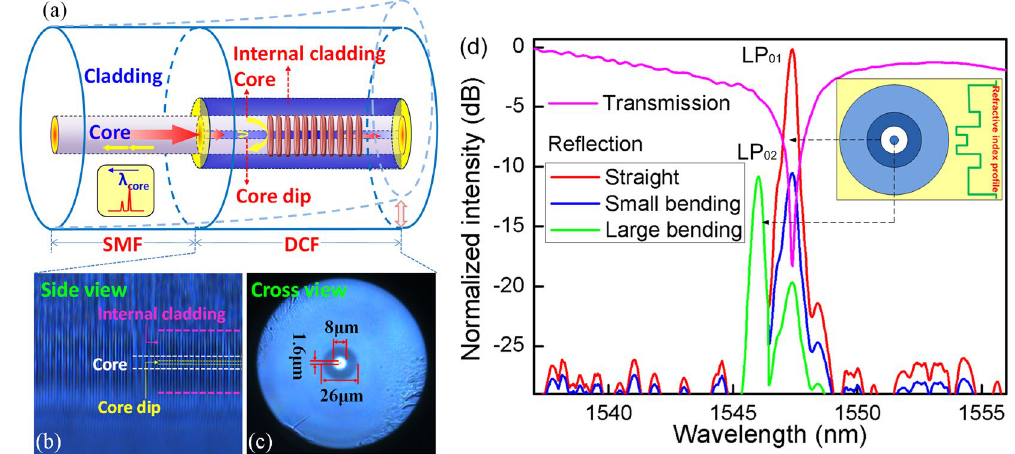
Figure 1. ( a ) Schematic of the DCF-FBG accelerometer, ( b ) side-view images of the DCF with grating inscription, ( c ) cross-view image of DCF, ( d ) transmission and reflection spectra of DCF-FBG versus fiber bending, where on the short wavelength side the green line overwrites the previous ones (red and blue lines). Inset shows the transverse refractive index